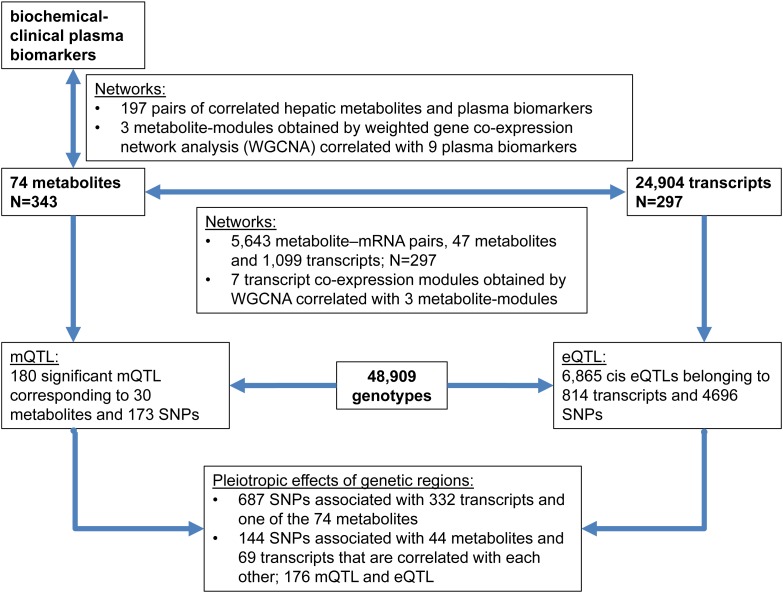
Outline of experimental flow and summary of main results.